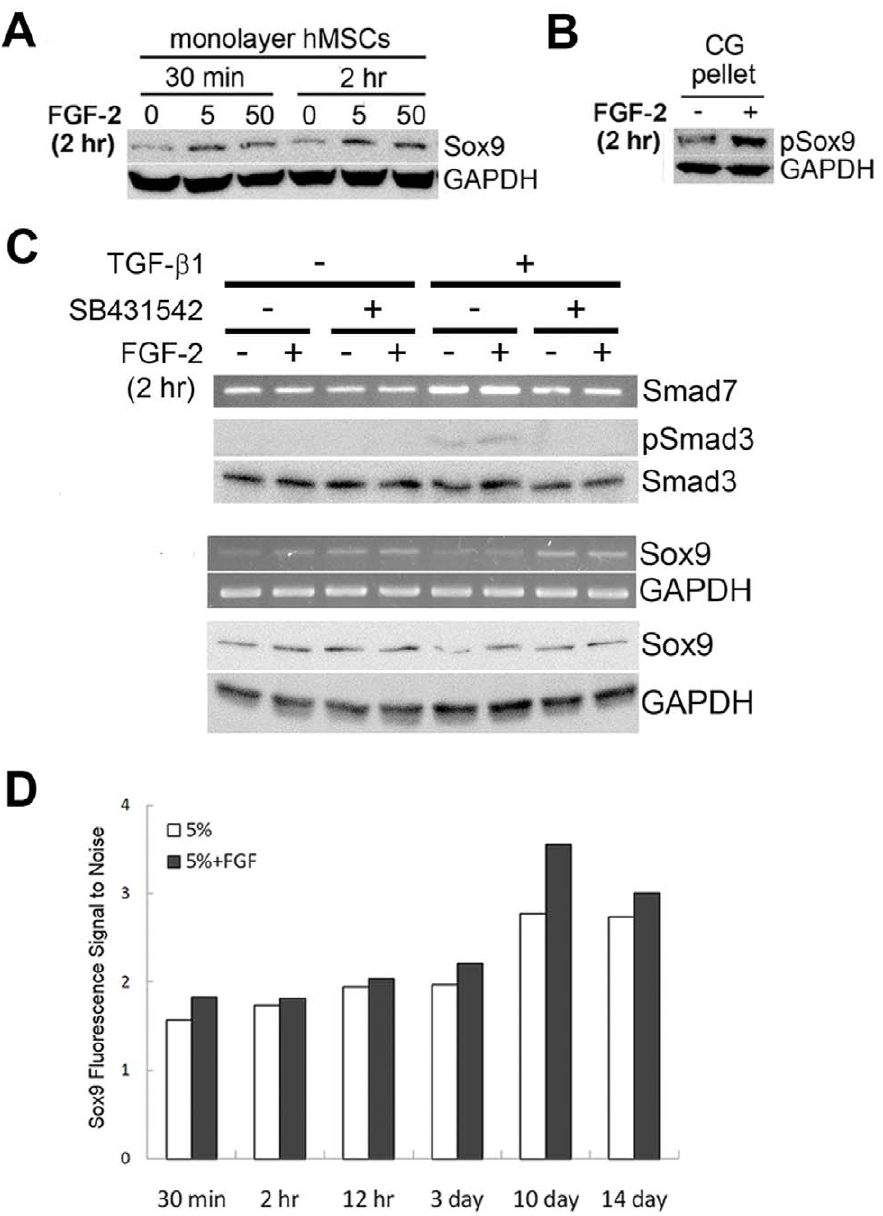
Figure 4. FGF-2 primes hMSCs for CG by increasing basal Sox9 protein levels. (A) Human MSCs were exposed to FGF-2 for 30 minutes or 2 hours and analyzed for Sox9 protein levels prior to pellet culture by Western blot analysis. Exposure to 5 and 50 ng/mL FGF-2 led to increased Sox9 protein levels in a dose-dependent manner. GAPDH was used as a loading control. (B) Human MSCs were exposed to FGF-2 for 2 hours and chondrogenically-induced in pellet culture. FGF-2-expanded hMSCs ( + ) showed elevated pSox9 protein levels by Western blot analysis.GAPDHwas used as a loading control. (C) Human MSCs were treated with or without SB431542 for 15 minutes, exposed to combinations of 5 ng/mL FGF-2, 10 ng/mL TGF- b 1 and 10 m M SB431542 for 2 hours, and analyzed for Sox9 mRNA and protein levels by end-point PCR and Western blot analysis, respectively. Exposure to FGF-2 led to increased Sox9 mRNA and protein levels, while TGF- b 1 reduced Sox9 expression. Smad7 gene and pSmad3 protein levels were analyzed to confirmsuccessfulknockdown of TGF- b signaling. GAPDH was used as a loading control. (D) Human MSCs were expanded inFGF-2 for varying durationsof time andanalyzed for Sox9 protein usingflow cytometry.Sox9 protein levels per cell were elevated at all time points after FGF-2 exposure compared to the control and gradually increased with longer exposures. Values are represented as fluorescence signal to noise ratios using geometric means.